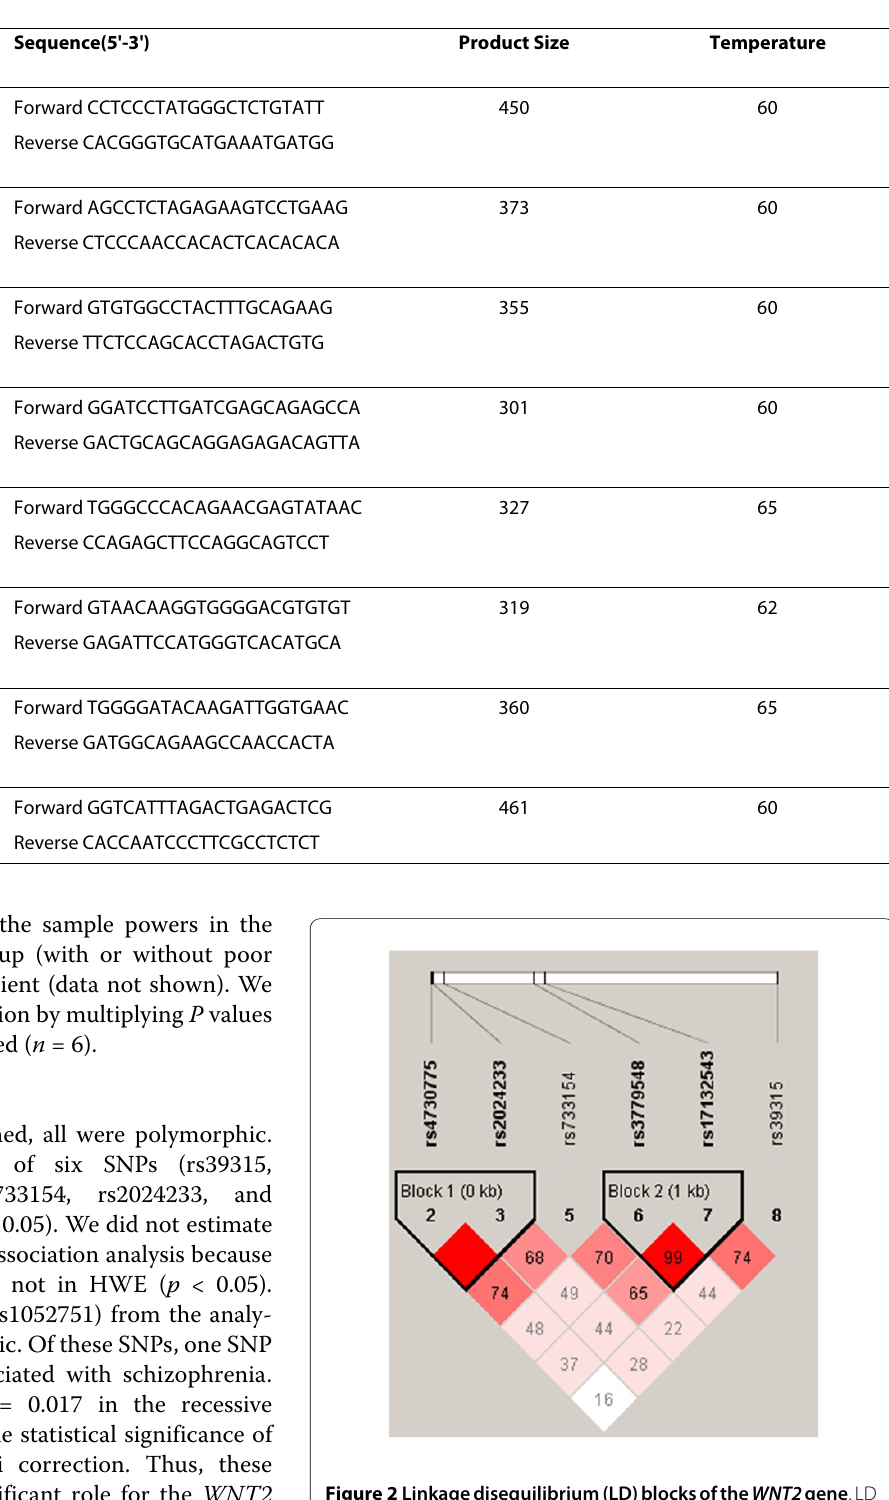
Figure 2 Linkage disequilibrium (LD) blocks of the WNT2 gene . LD coefficient (|D'|) and LD blocks among WNT2 SNPs. Block 1 consists of rs4730775 and rs2024233. Block 2 comprises rs3779548 and